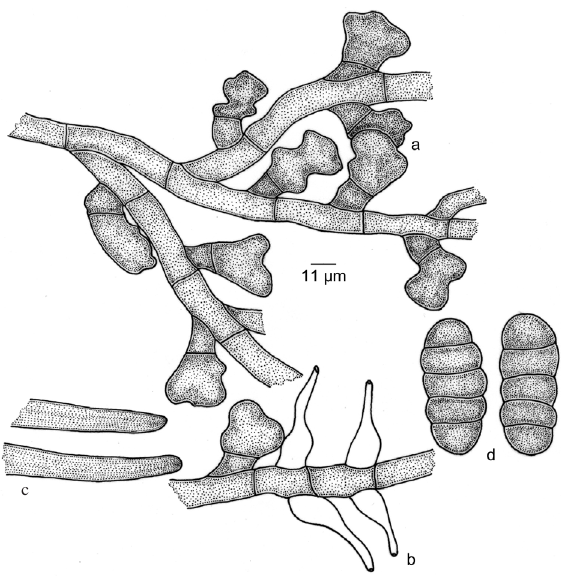
Figure 1. Irenopsis trichiliae sp. nov. a - Appressorium; b - Phialide; c - Apical portion of the perith- ecial setae; d -